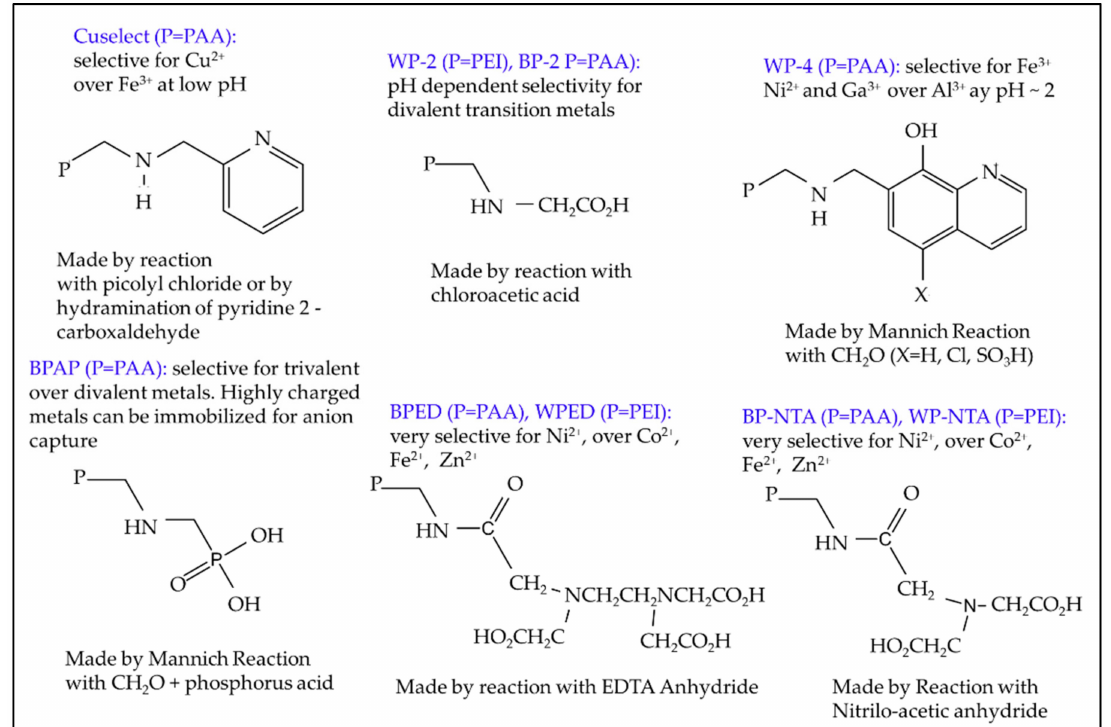
Figure 14. Ligands modified Silica Polyamine Composites (SPCs) and their applications to